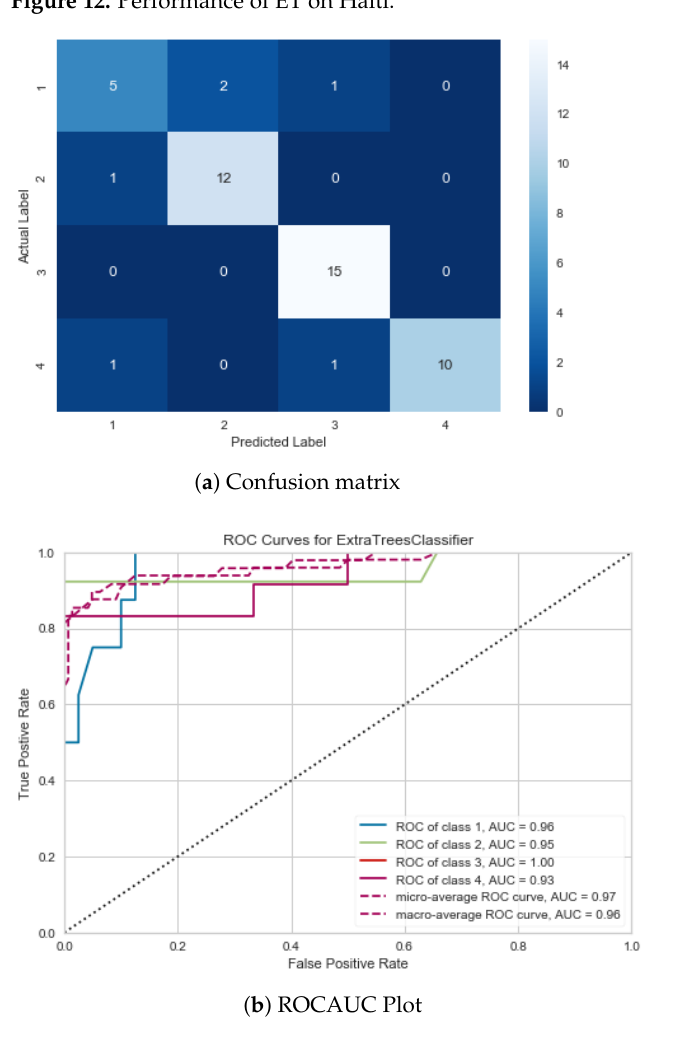
Figure 13. Performance of ET on